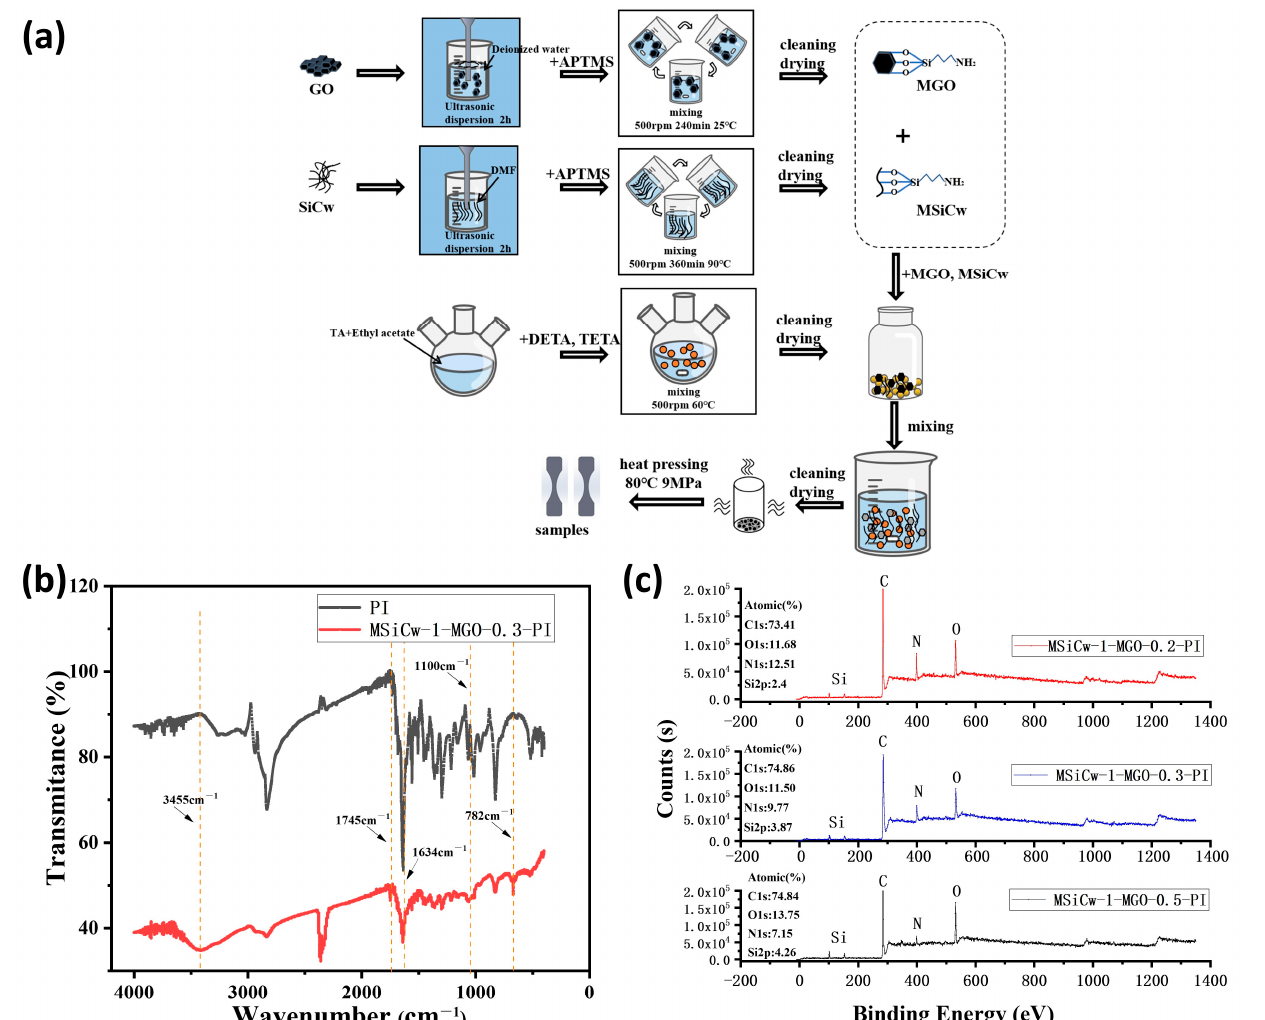
Figure 2. Flow chart of preparation of MSiCw-MGO-PI composites ( a ). FTIR spectra: polyimine and MSiCw-1-MGO-0.3-PI ( b ). Wide-scan survey XPS spectrum of MSiCw-MGO-PI composites ( c